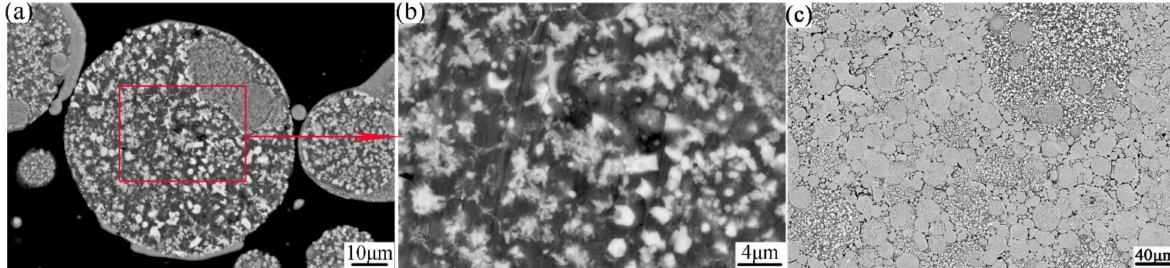
Figure 3. ( a ) lower amplification ( b ) higher amplification SEM/BSE of the atomised powder particles; ( c ) SEM/BSE of the green sample with the compaction energy of 1325 J.